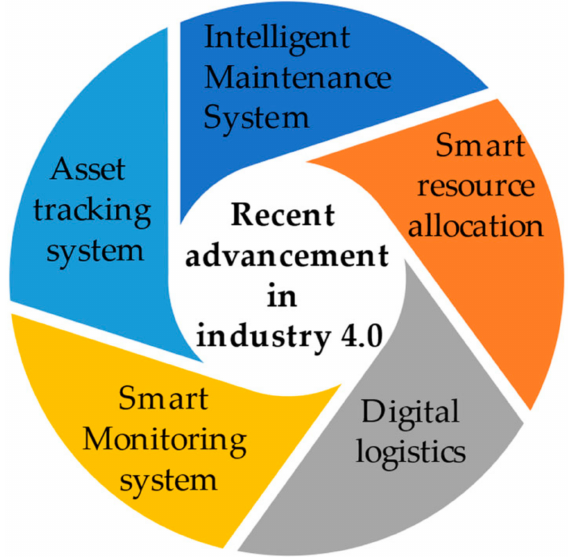
Figure 4. Recent advancements in operations management in production shop floor management in industry